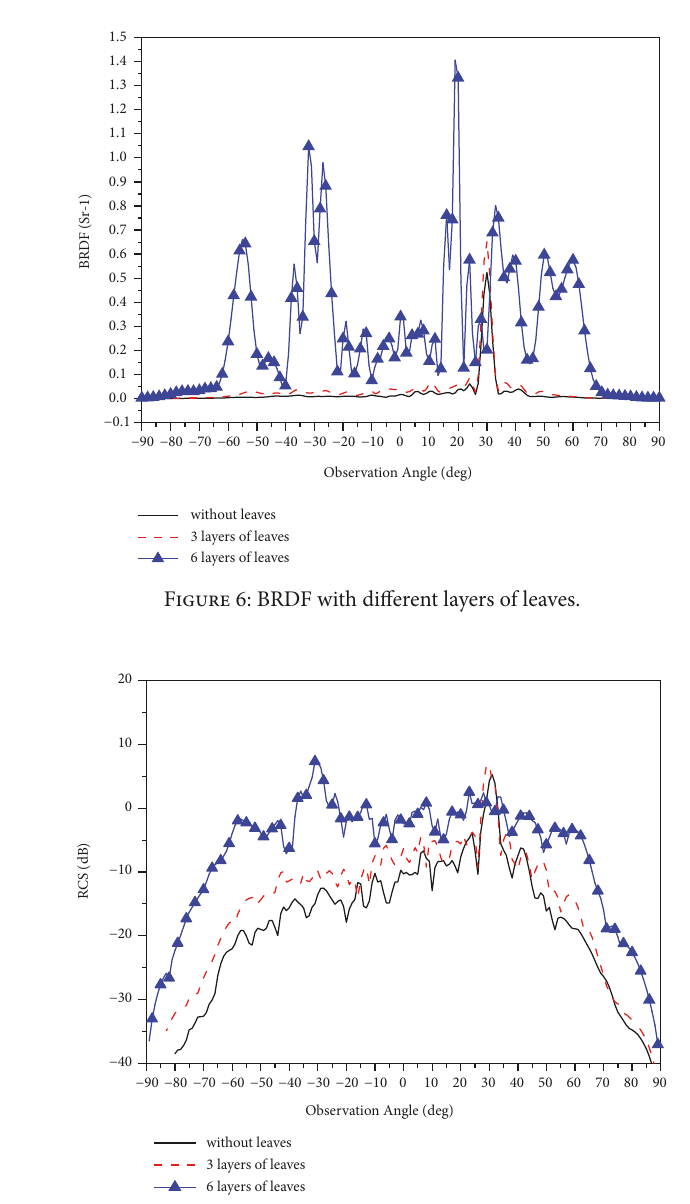
Figure 7: RCS with different layers of